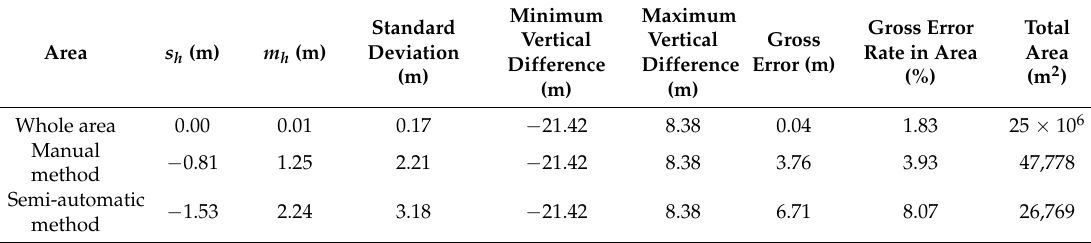
Table 1. Calculated characteristics by volume difference of DMR 5G and DMR 5G+ (absolute error as m h , systematic errors s h , gross error as a triple of the standard deviation between elevations of both models).